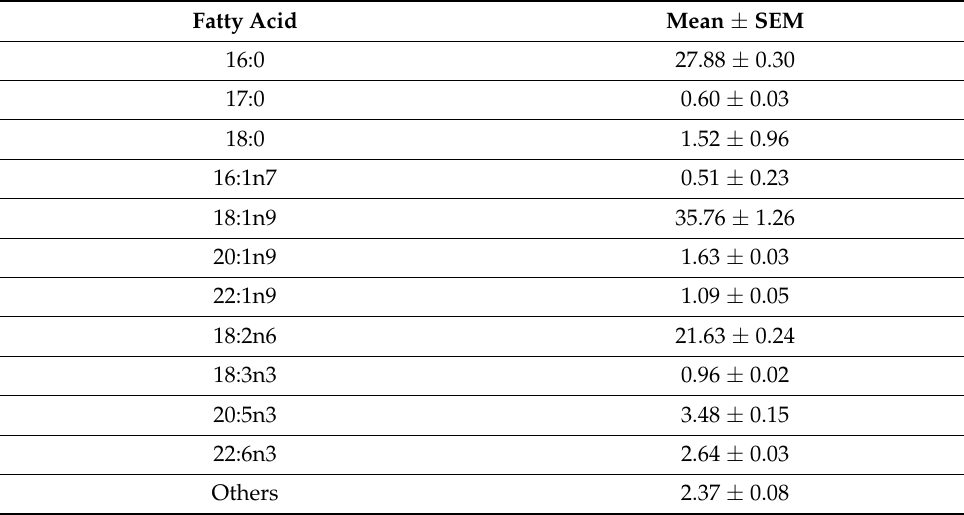
Table A1. Fatty acid composition of commercial snail diet. Values are shown as %, n =